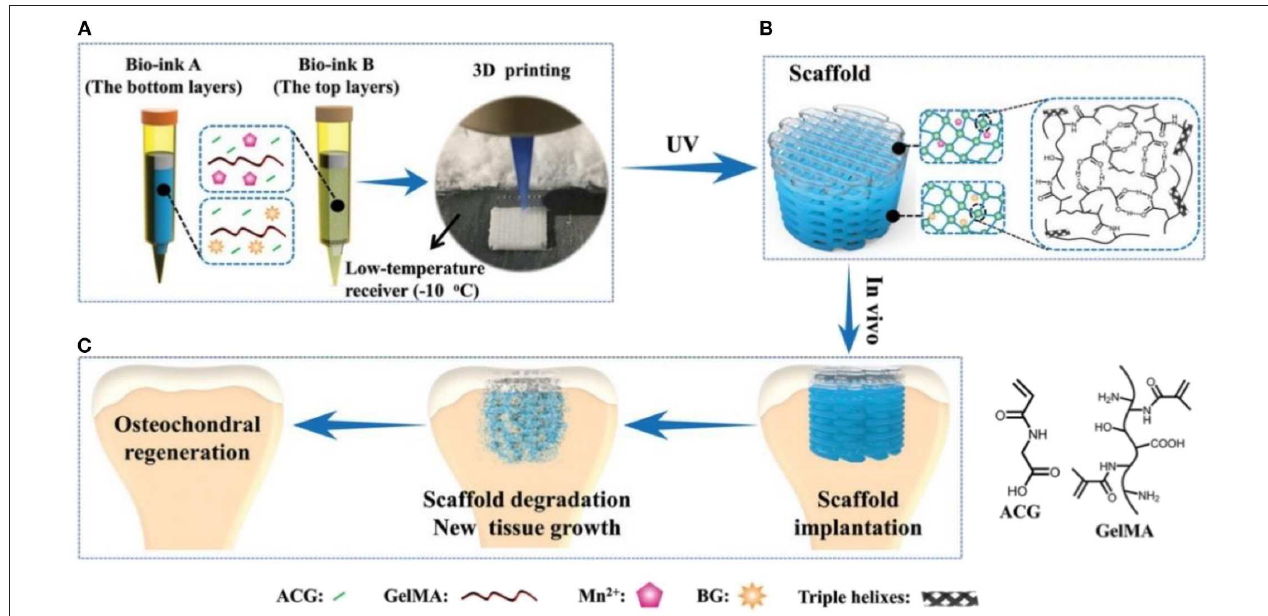
FIGURE 5 | Schematic illustration of the biohybrid gradient scaffolds for osteochondral repair by 3D printing technology. (A) The compositions of bio-ink A and bio-ink B and 3D-printing method of hybrid gradient scaffolds assisted with a low-temperature receiver. (B) Formation of hydrogel scaffold after UV light-initiated polymerization with hydrogen bonding interactions. (C) Osteochondral repair treated with the biohybrid gradient PACG-GelMA scaffold, with Mn 2 + and BG being loaded on the top and bottom layers, respectively. Reproduced from Gao et al. (2019) with permission from Copyright 2019